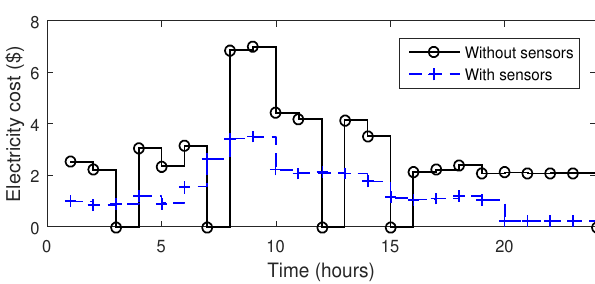
Figure 14. Daily electricity cost of ua appliances.